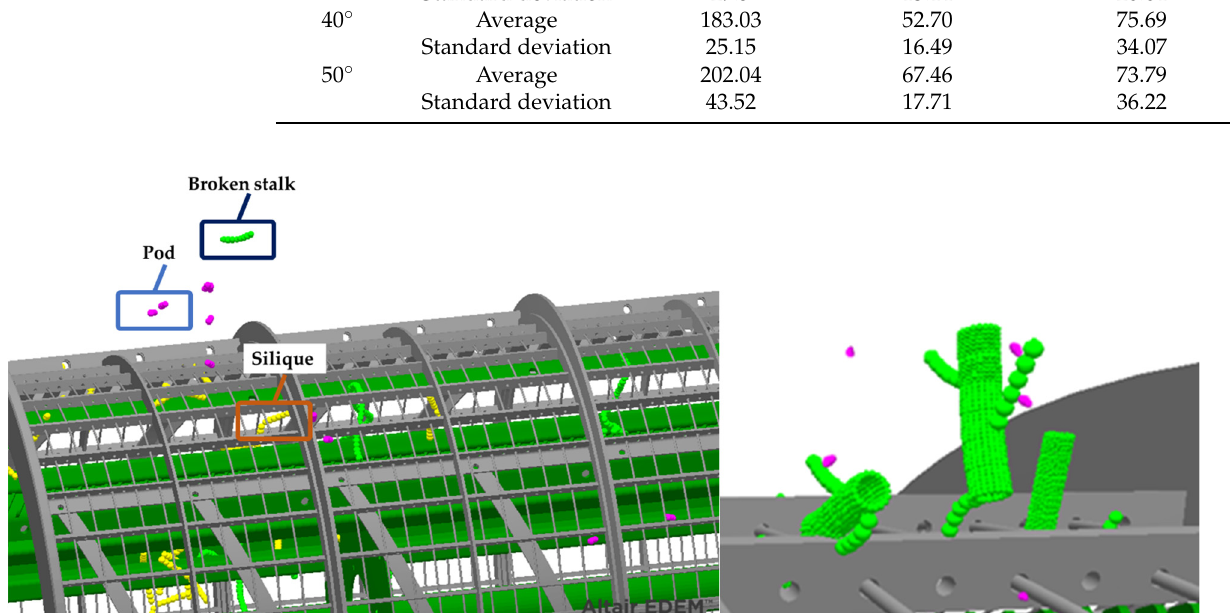
Agriculture 2022 , 12 , x FOR PEER REVIEW 10 of 22 Figure 7. Force cloud diagram of different type of particles. Figure 7. Force cloud diagram of different type of particles.